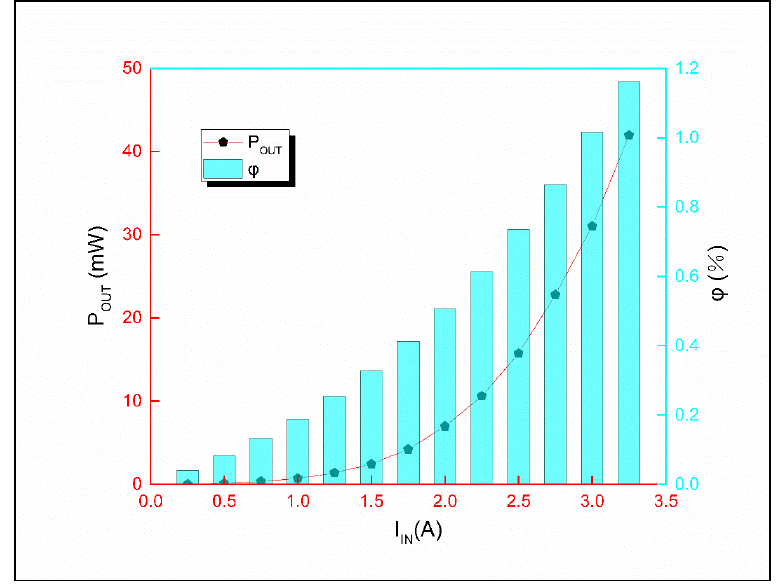
Figure 7. Dependence of P OUT , ϕ on input current.